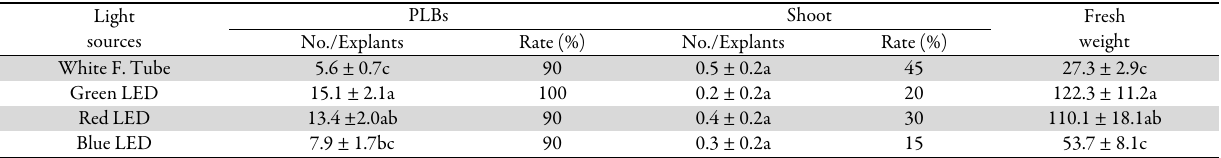
Table 1. In vitro culture of C. devonianum PLBs in modified MS medium supplemented with sucrose (20 g L -1 with modified MS medium) under different sources of